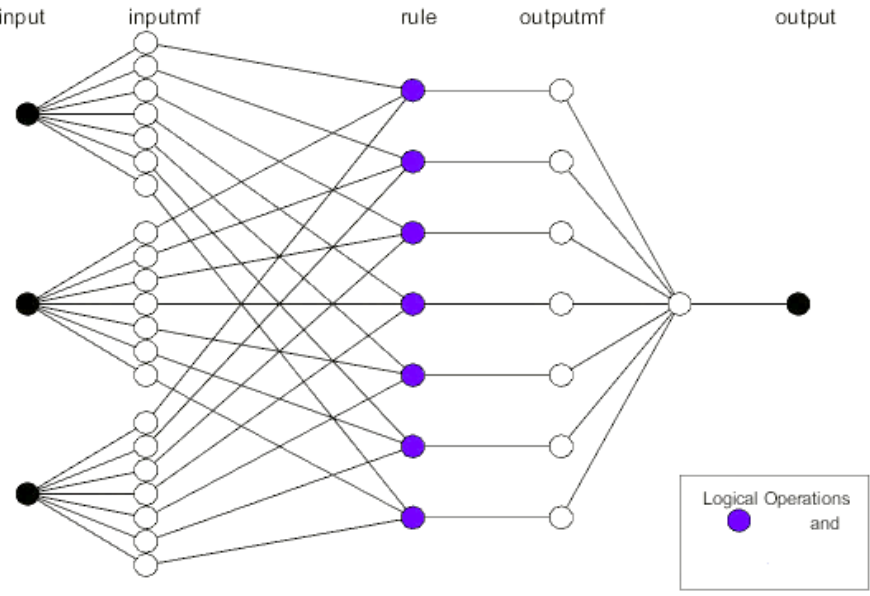
Figure 9. The input layer (time, day ( In 1 ) , temperature ( ◦ C, In 2) and pH ( In 3 ) ) and output layer (inhibition zone of Erwinia carotovora ) used in the adaptive neuro-fuzzy inference system (ANFIS) and artificial neural network (ANN)